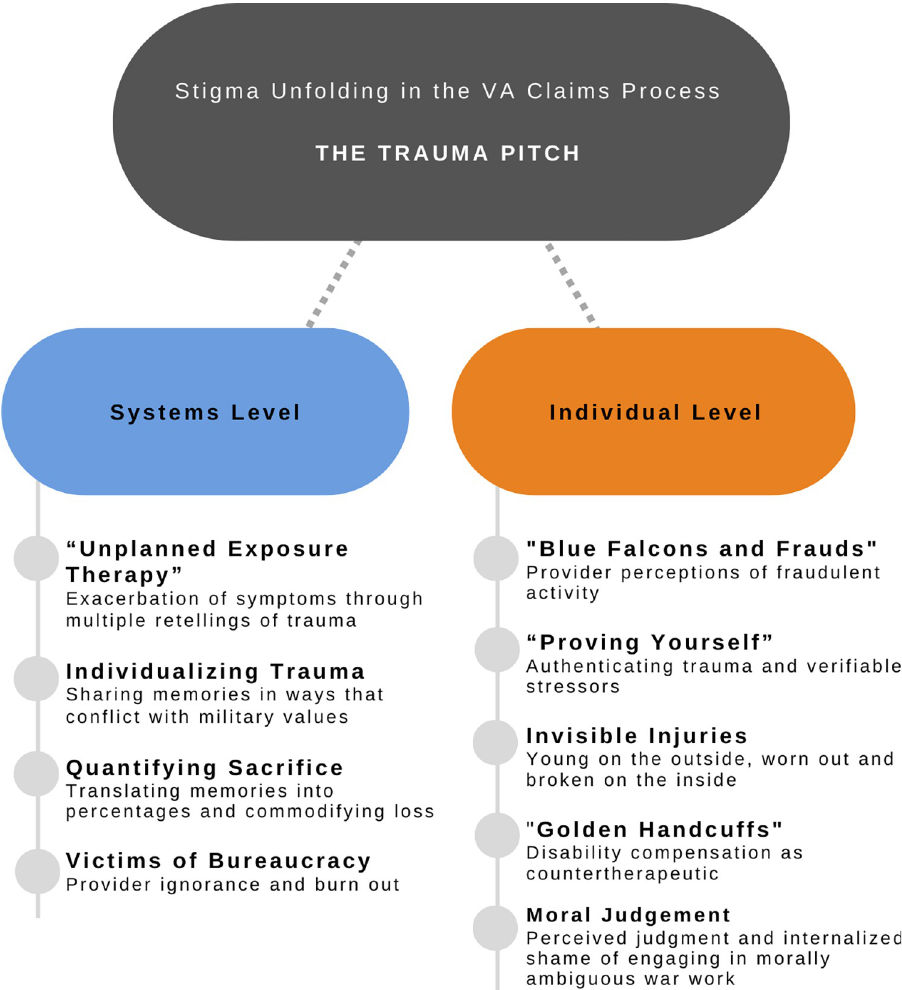
Fig 2. How stigma unfolds for veterans in the VA disability determination process. The “trauma pitch” impacted veterans via systemic processes and individual interactions. https://doi.org/10.1371/journal.pone.0267424.g002 PLOS ONE | https://doi.org/10.1371/journal.pone.0267424 August 31,